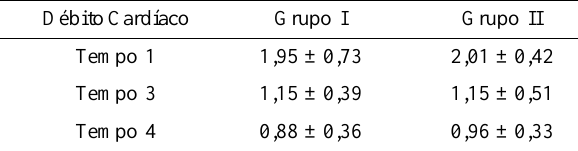
Teste Estatístico - Análise de Variância de Duplo